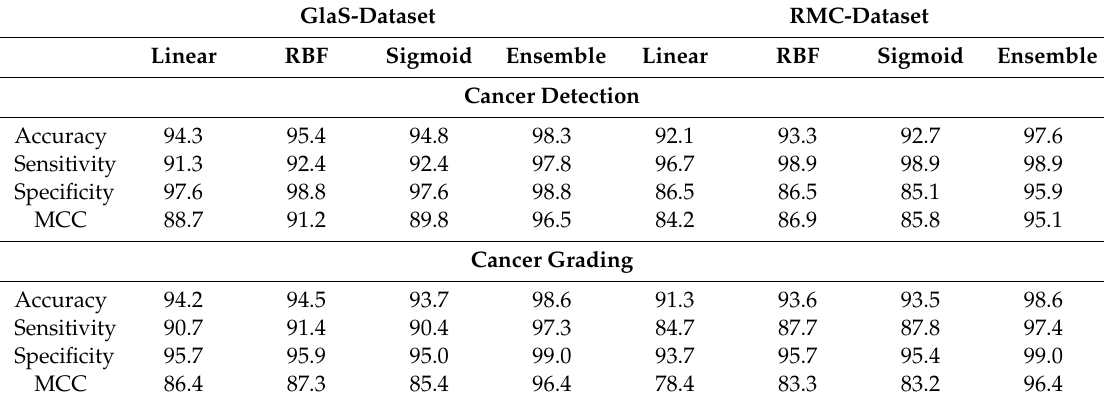
Table 3. Performance of the meta-classifier for both data sets (results are shown for individual and ensemble classifier).